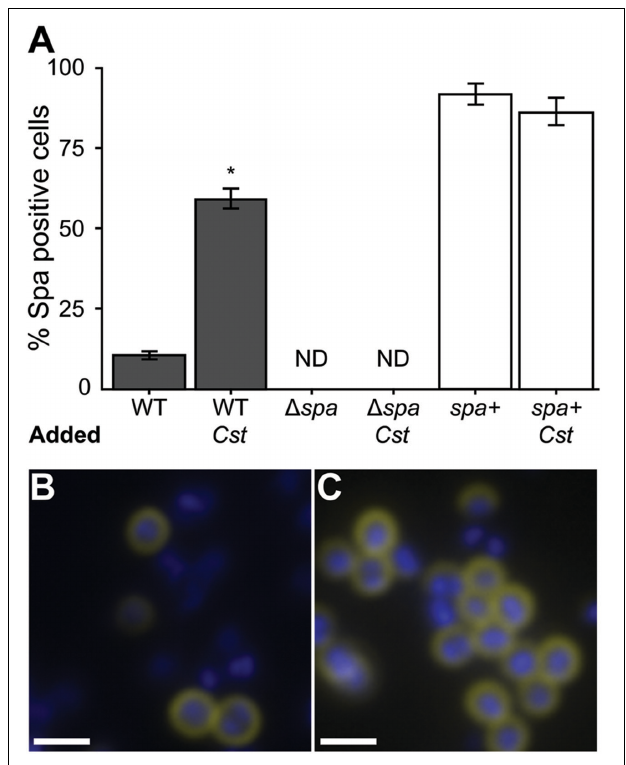
FIGURE 3 | The proportion of S. aureus cells with active surface-associated SpA increases in coculture with C. striatum . S. aureus strains were grown in mono- versus coculture with C. striatum under conditions identical to those used in Table 1 . SpA activity was detected by observing SpA-mediated capture of FITC-conjugated goat IgG (yellow in B,C ). Cells were counterstained with DAPI (blue in B,C ). Cell intensity was quantified for all S. aureus strains in three fields of view at 1000x magnification each from 3 biological replicates under identical exposure settings. (A) ImageJ software was used to count total cells versus FITC-positive cells. 10% of wild-type S. aureus (WT) were positive for SpA activity in monoculture compared to 60% in coculture with C. striatum ( Cst ). The spa -deletion mutant carrying the empty expression vector ( (cid:49) spa ) had no detectable FITC staining (ND). The spa -deletion mutant carrying an expression vector expressing spa from its native promoter ( spa + ) had FITC-positive cells in both conditions consistent with this construct producing SpA above wt levels. Error bars represent SEM. Data were analyzed by two-tailed Student’s t -test with Bonferroni correction for multiple testing ( ∗ p < 0.003). Representative micrographs of wild-type S. aureus cells (blue) in mono- (B) versus coculture (C) stained for SpA (yellow) at the cell surface. Scale bars represent 1.5 µ